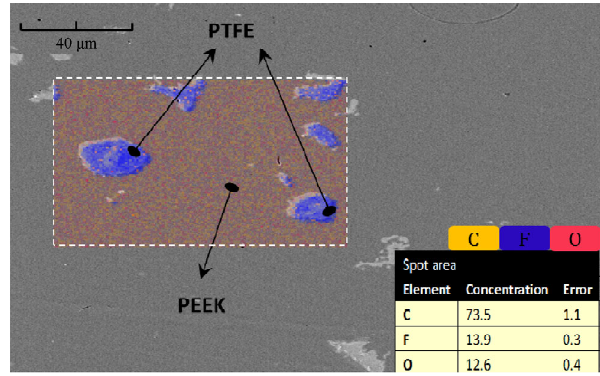
Fig. 1 Typical EDS spectra of PEEK disk at different locations.